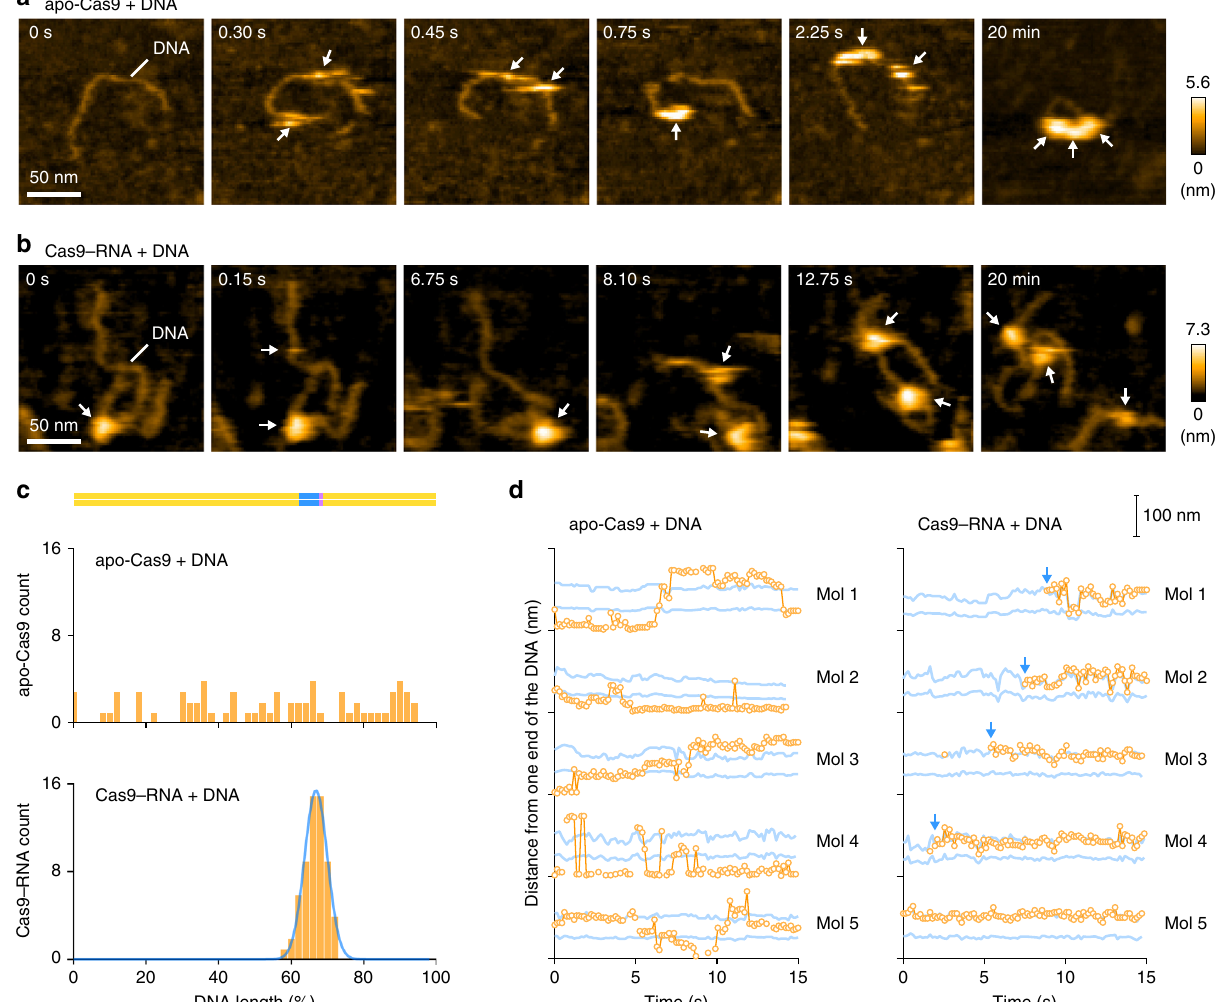
Fig. 5 HS-AFM observations of target interrogation by Cas9 – RNA. a , b Sequential HS-AFM images of the DNA after addition of apo-Cas9 ( a ) and Cas9 – RNA ( b ) on the lipid bilayer. Apo-Cas9 and Cas9 – RNA are indicated by white arrows. The scale bars are 50 nm. c Binding distributions of apo-Cas9 ( n = 69) and Cas9 – RNA ( n = 61). The binding distribution of Cas9 – RNA fi ts a Gaussian curve, with the peak corresponding to the target site. d Time courses of the binding positions of apo-Cas9 and Cas9 – RNA. The distances from one end of the DNA were measured for fi ve representative apo-Cas9 (left) and Cas9 – RNA (right) molecules. Blue lines indicate the positions 200 and 400bp from one end of the DNA (the potential target sites). Blue arrows indicate the binding of Cas9 – RNA to the target